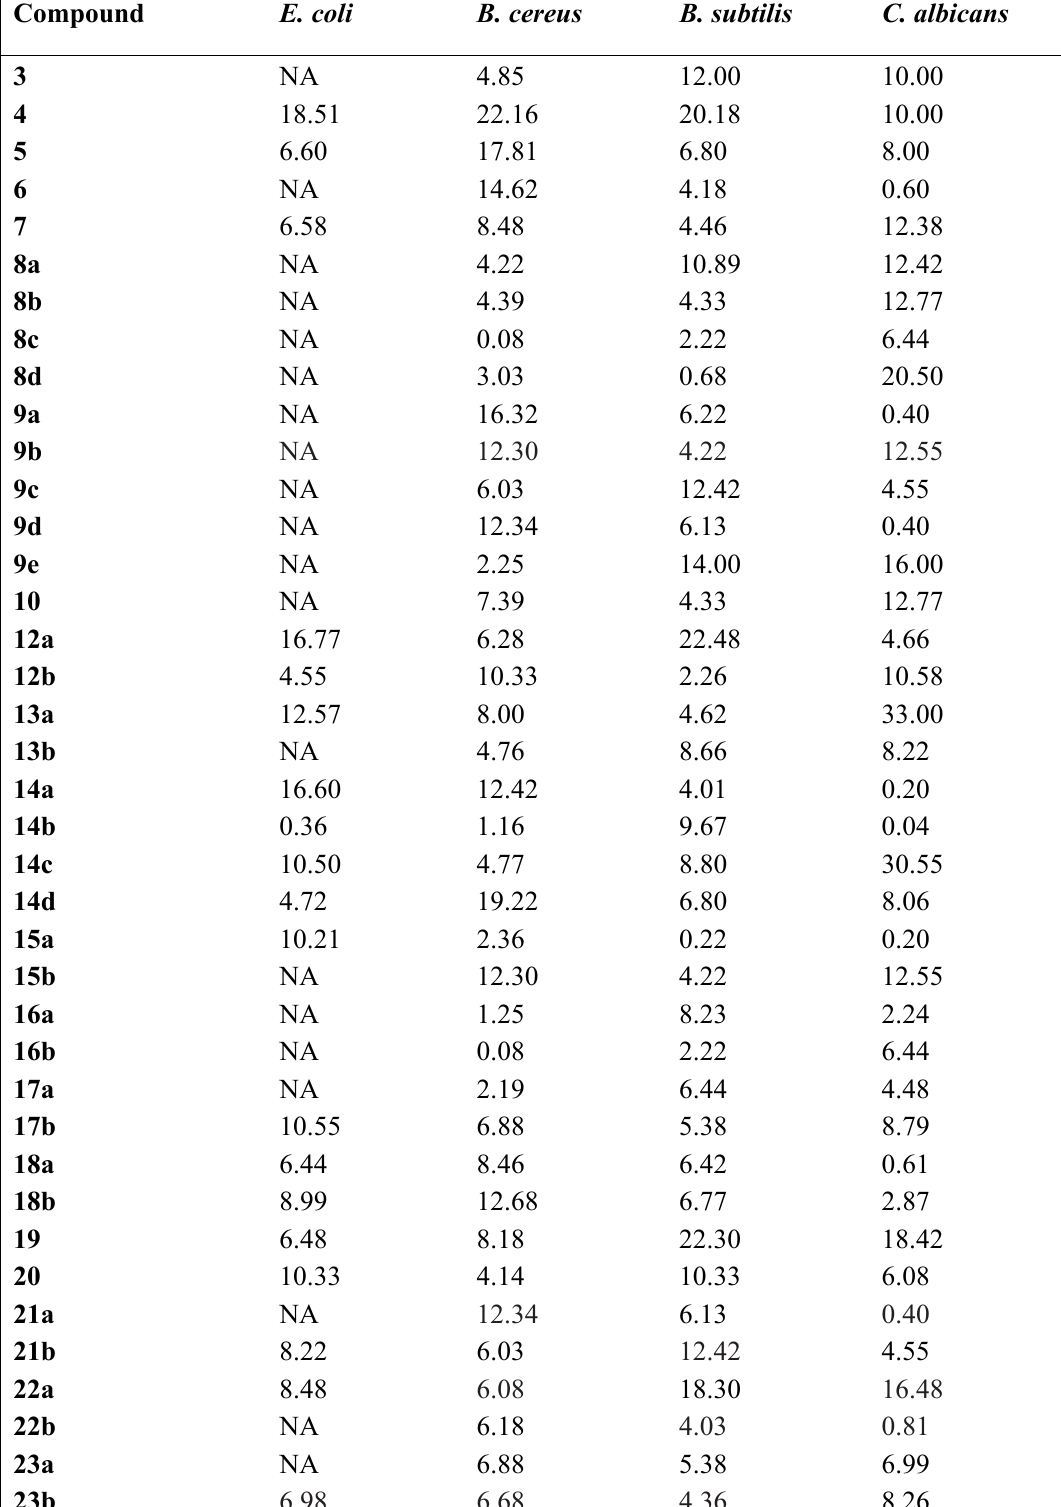
Table 2. Antimicrobial and antifungal evaluations of the synthesized compounds MIC (mg/mL).